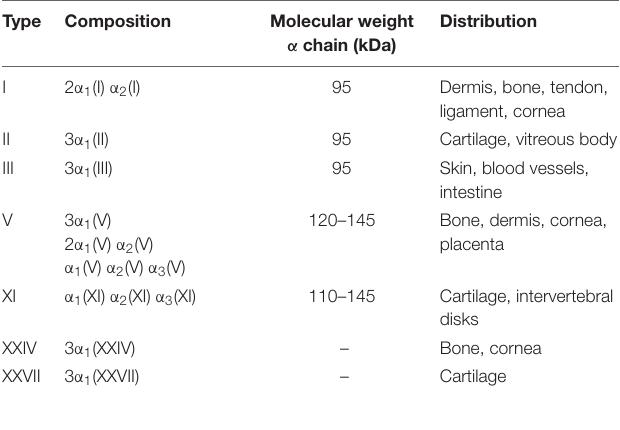
TABLE 1 | Fibril-forming collagens found in vertebrates (Shoulders and Raines, 2009; Sorushanova et al., 2019). Type